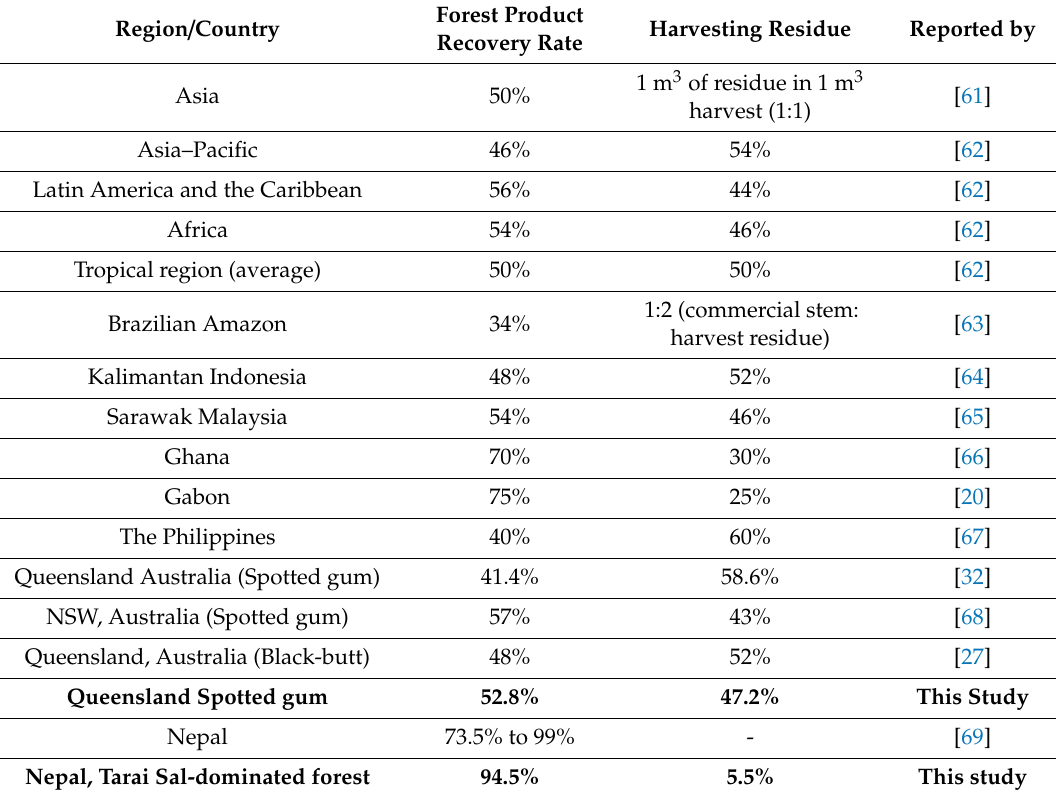
Table 9. Forest product recovery rate reported by earlier